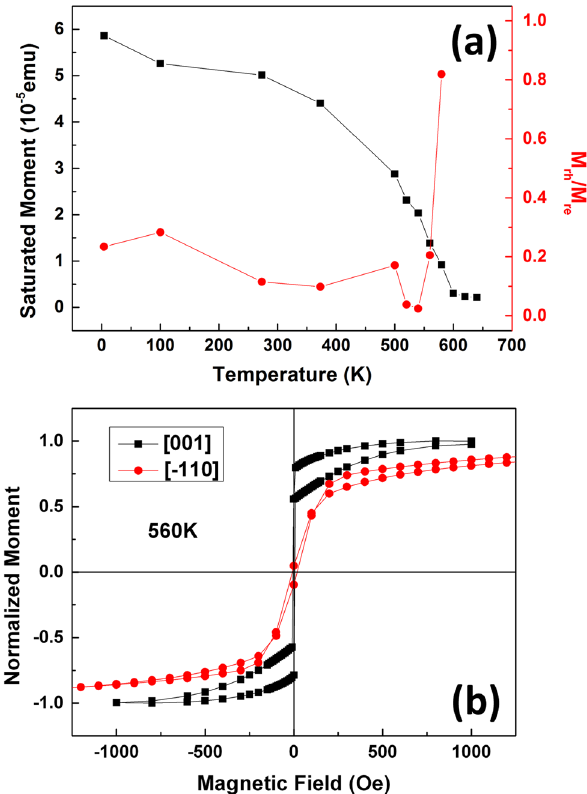
Fig. 2 Thickness dependence of the uniaxial anisotropy. a NiO layer thickness dependences of the easy axis coercive fi eld H c[001] and the M r ratio in the Ni(10 nm)/NiO/SrTiO 3 (110) heterostructure. b Ni layer thickness dependences of easy axis coercive fi eld and M r ratio in the Ni/NiO(12 nm)/SrTiO 3 (110) heterostructure